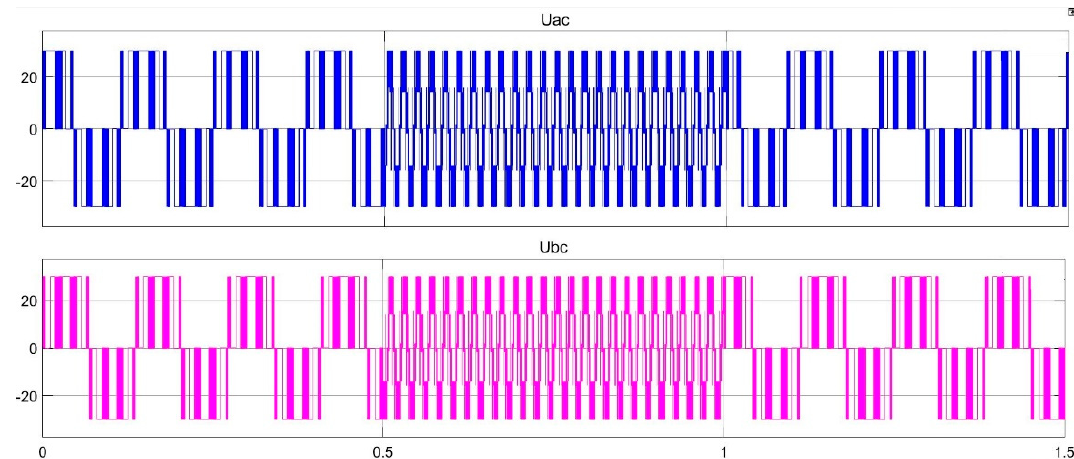
Figure 17. The simulation voltage waveform of the whole conversion process.